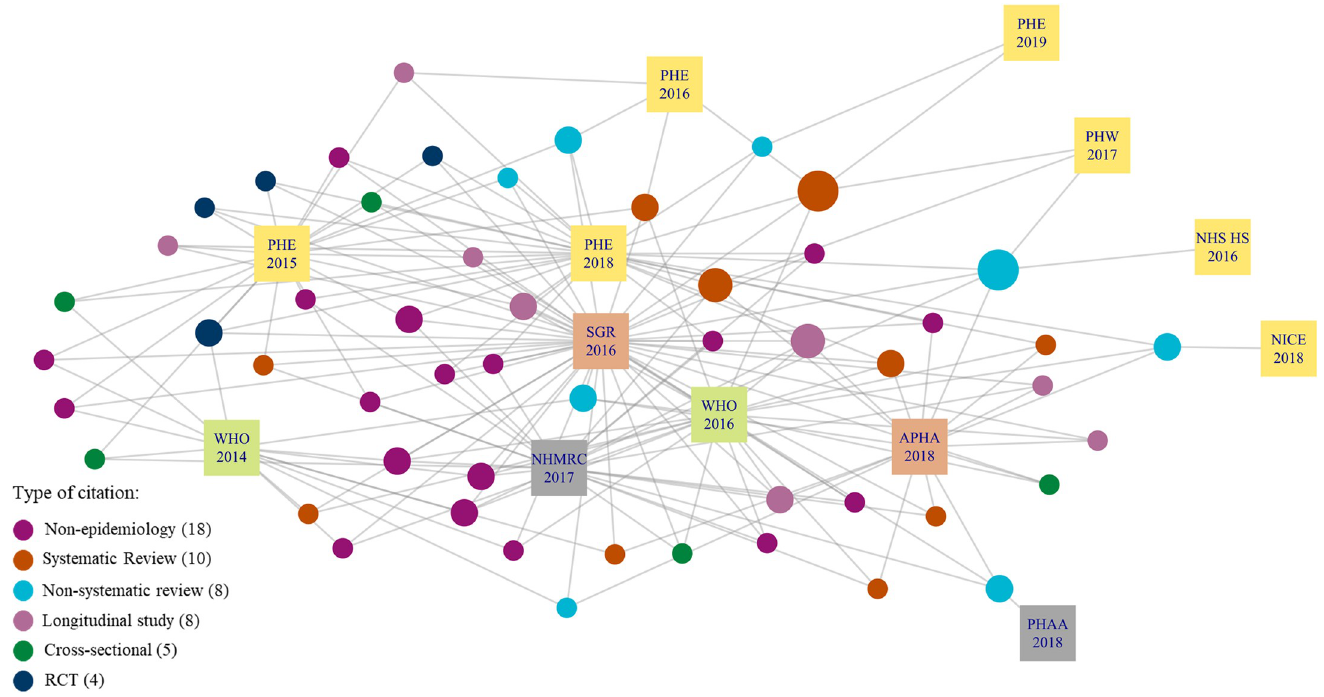
Fig 3. Citation network showing the study design of the 53 highly cited citations across 13 recommendation documents.